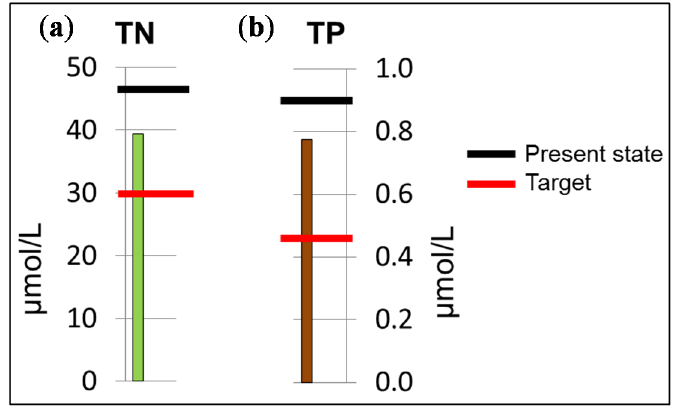
(horizontal lines) according to the